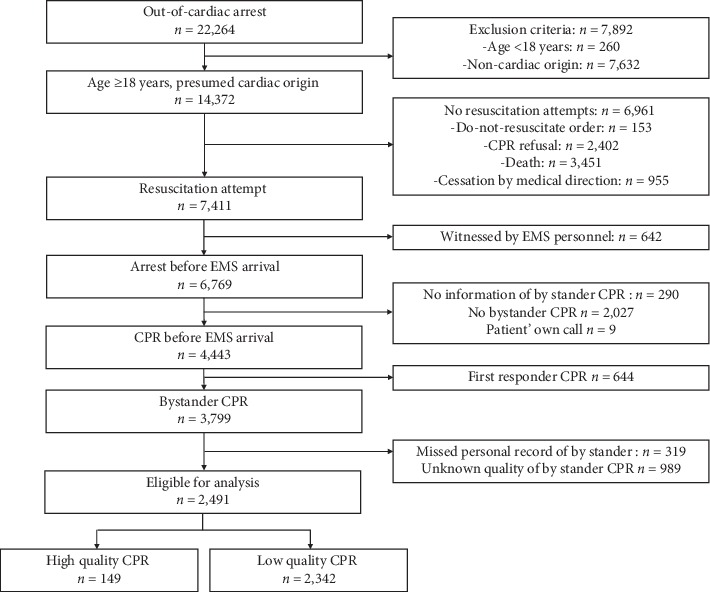
Study flow diagram.